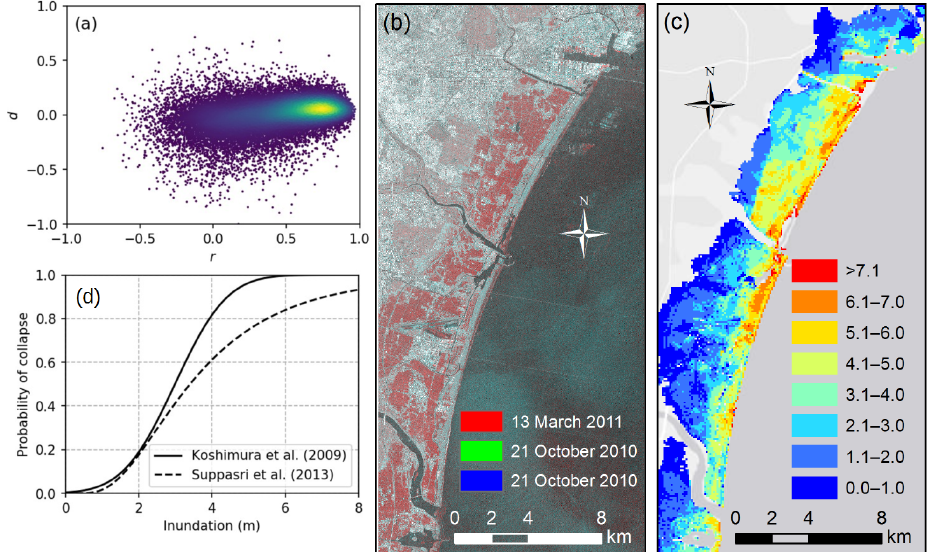
Figure 9. ( a ) Scatter plot of the data using the average difference in backscattering between the disaster intensity d and the correlation coefficient r . ( b ) RGB composite image made of TerraSAR-X data acquired on 13 March 2011, and 21 October 2010. ( c ) Known innundation map used for the disaster intensity. ( d ) Empirical fragility functions of buildings proposed by Koshimura et al. [53] and Suppasri et al. in [54]; The figure is modified from [14] with the corresponding author’s permission. They apply their method to TerraSAR-X images of the Sendai bay area taken on October 12th 2010 and March 13th 2011. They use input features of the form x i = { 1, d , r